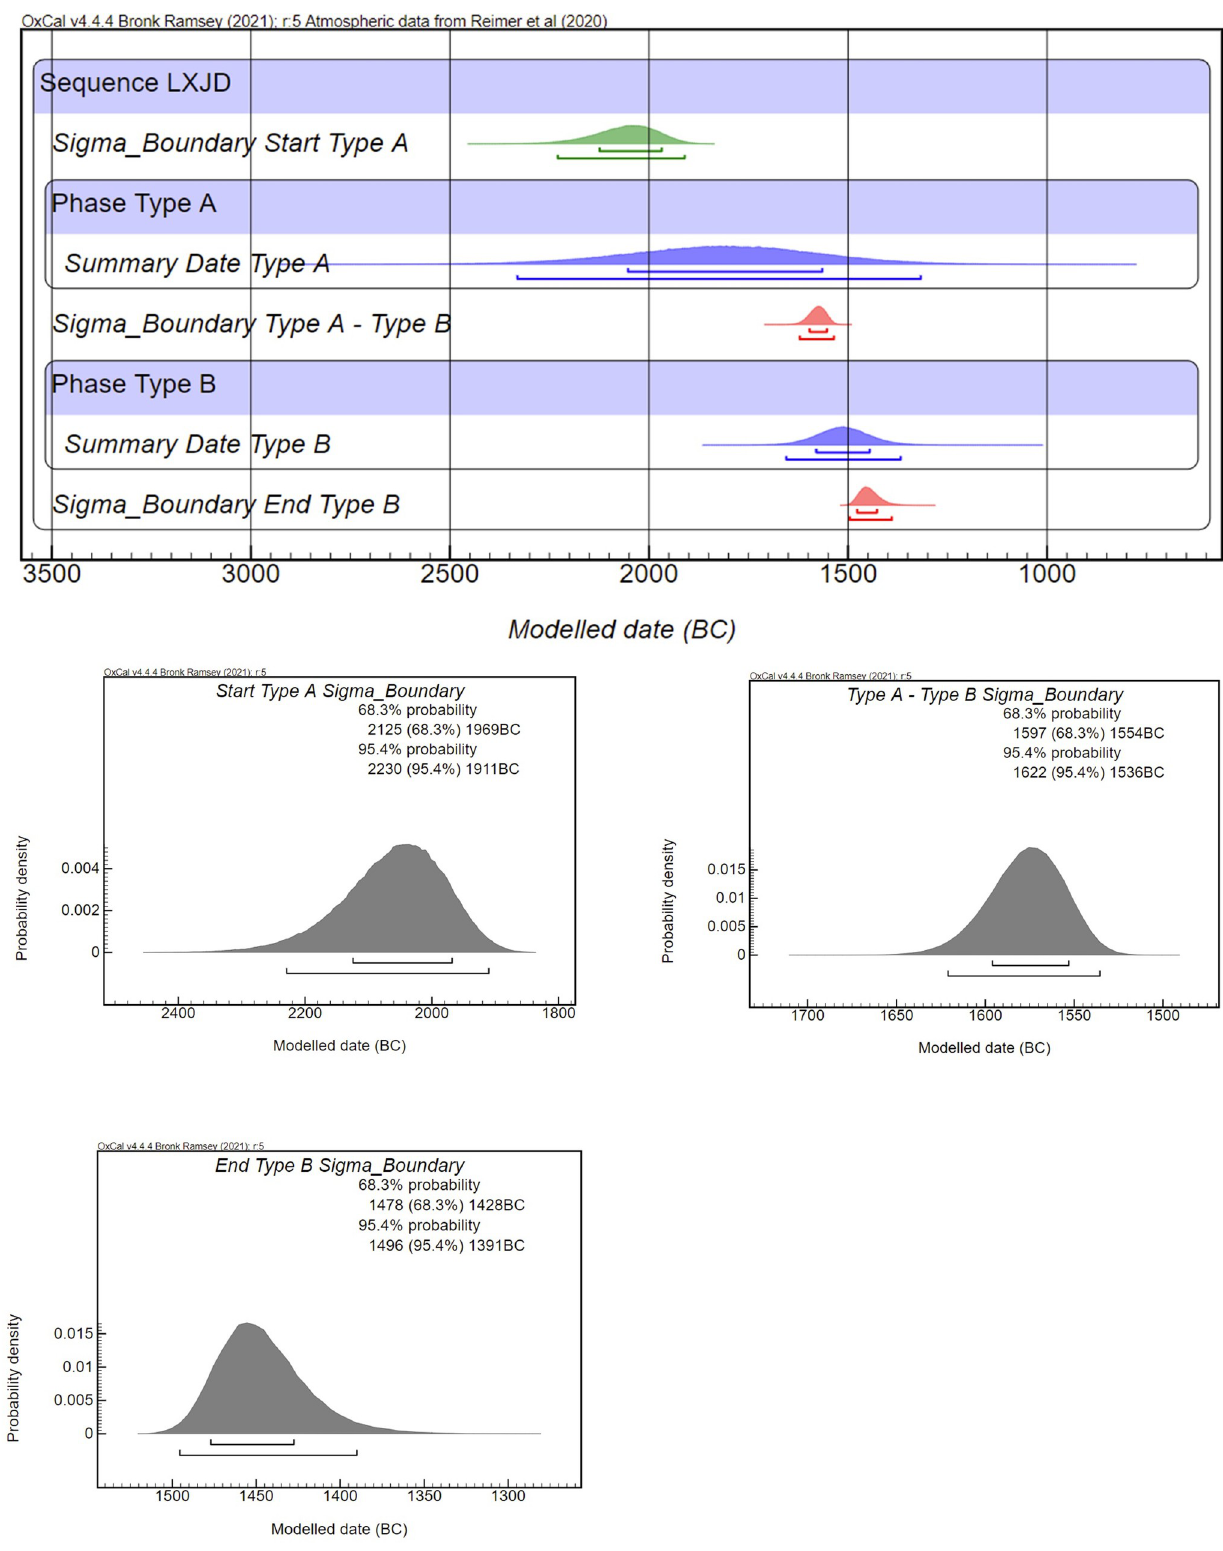
Fig 4. Summary dates and modeled start and end dates for type A and type B sites.